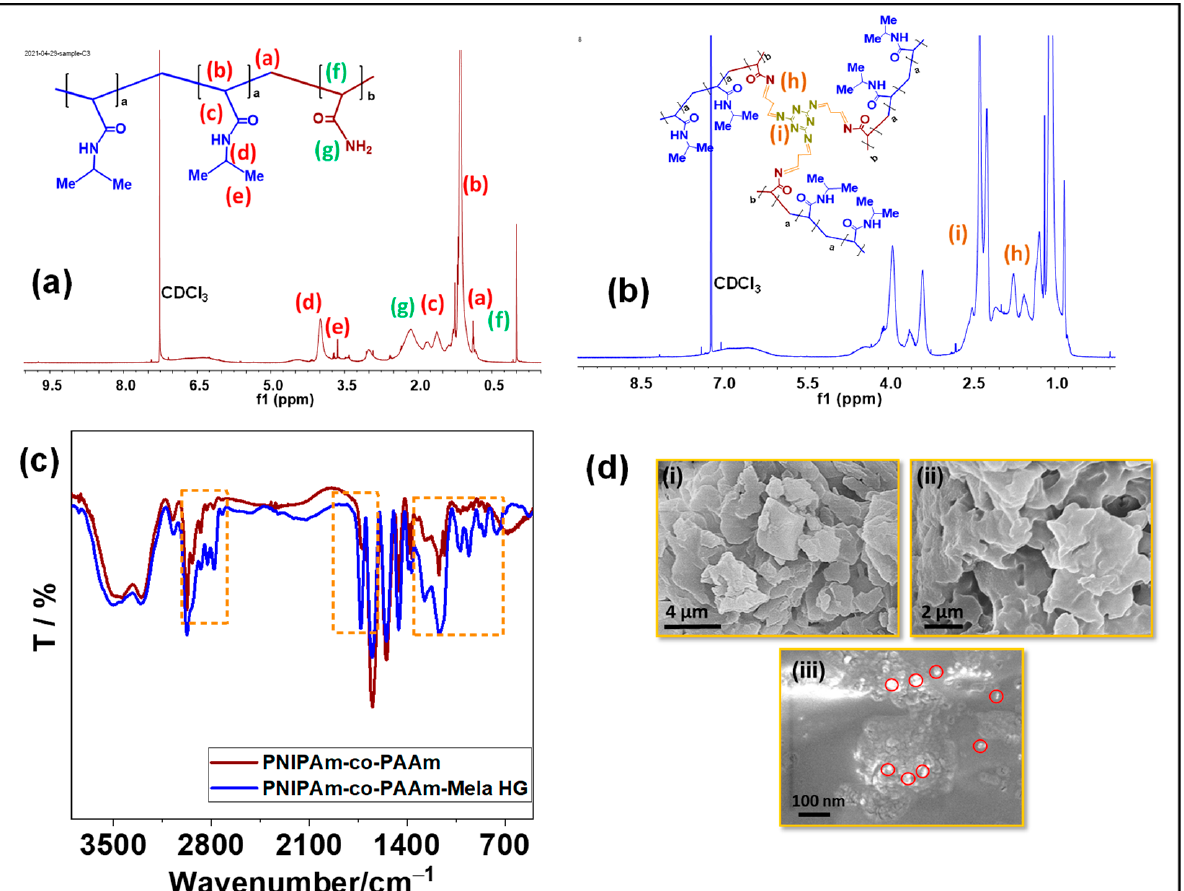
Figure 1. Characterization of PNIPAm-co-PAAm copolymer samples. ( a,b ) ¹H NMR spectrum; and ( c ) FT-IR analysis of PNIPAm-co-PAAm copolymer; and PNIPAm-co-PAAm-Mela HG samples, re- spectively. ( d ) SEM images of the ( i ) PNIPAm-co-PAAm copolymer; ( ii ) PNIPAm-co-PAAm-Mela HG; ( iii ) PNIPAm-co-PAAm-Mela/Cur HG samples, respectively. The red circles in figure ( d ) ( iii ) indicate the presence of Cur molecules in the hydrogel samples.